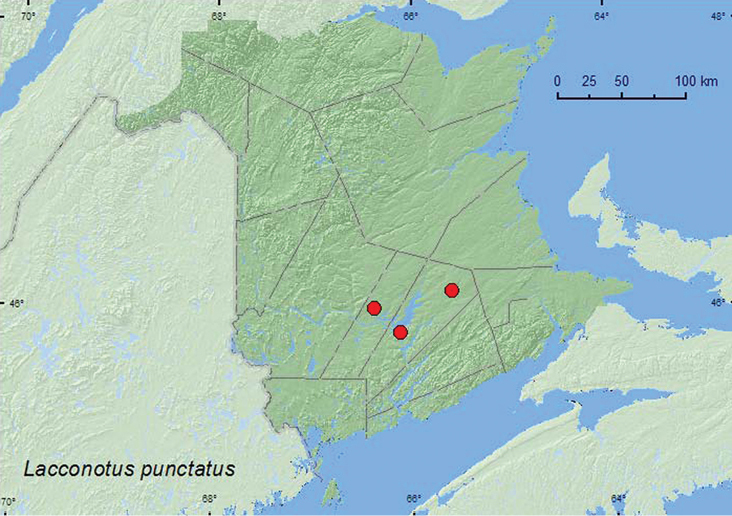
Collection localities in New Brunswick, Canada of Lacconotus punctatus.